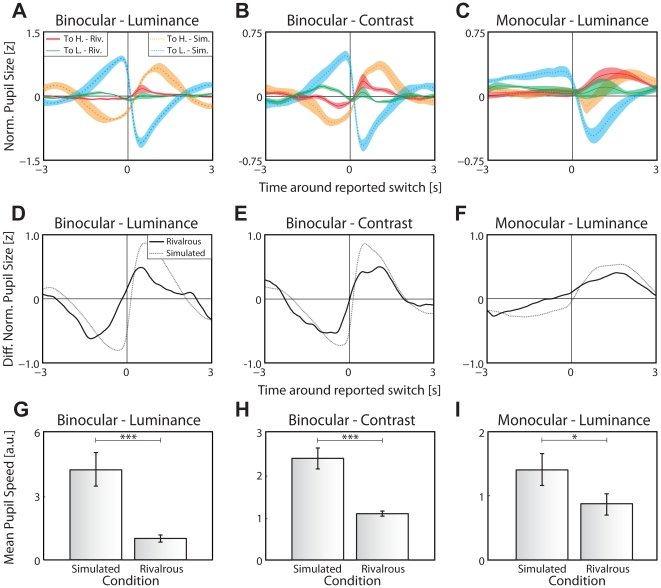
Experiment 2–Pupil graduality.(A–C) Average pupil size as a function of time relative to the perceptual transitions for rivalry (green and red traces) and physical stimulus changes (simulated rivalry, orange and cyan traces) per condition. (D–F) Difference in average pupil size per for rivalrous transitions (black solid traces) and simulated transitions. To compare rivalrous and simulated transitions, average pupil traces were normalized by dividing through the distance between the maximum and minimum of each trace per observer and trial. (G–I) Average horizontal pupil speed in a 0.2 time window around the pupil speed's zero crossing, mean and s.e.m. across observers for simulated (left) and real (right) rivalry. Pupil size was more gradual during rivalrous transitions as compared to simulated transitions.